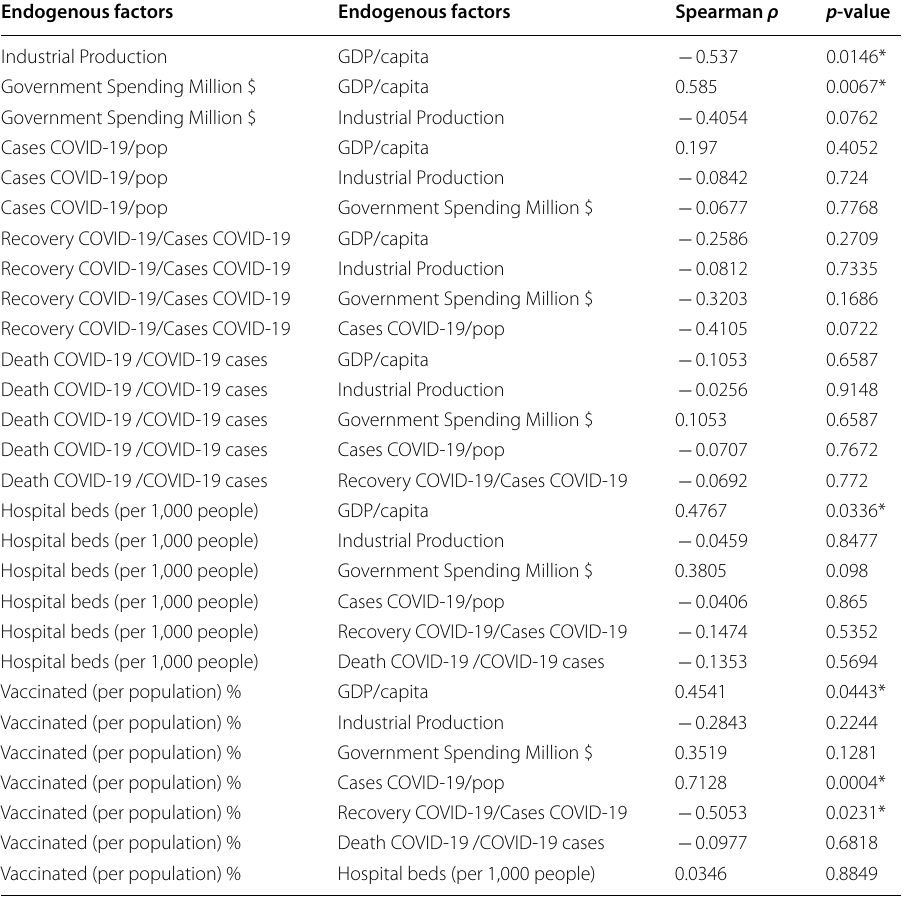
*Correlation is significant ( p ‑value <